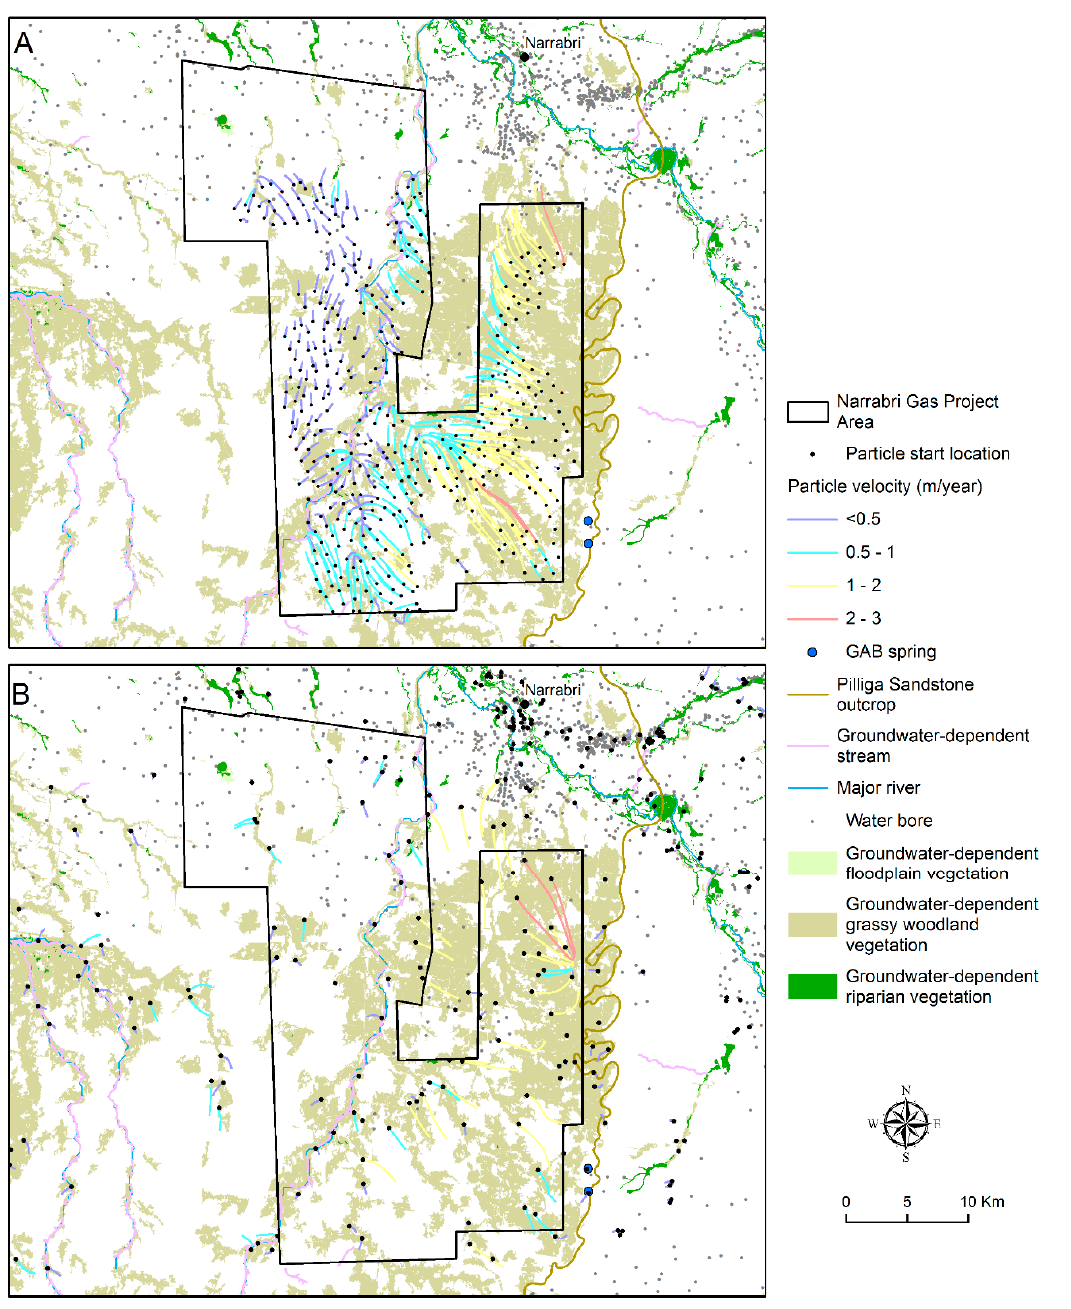
Figure 5. Average particle velocities from single 3000-year simulations released into the Pilliga Sandstone aquifer forward from CSG wells ( A ) and in reverse from selected receptor locations ( B ).